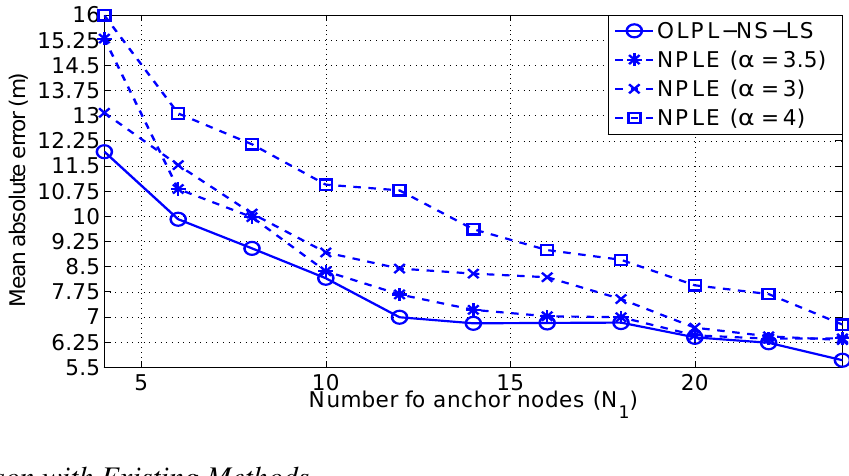
Figure 8. Mean absolute error versus number of anchor nodes ( N 1 ) ( solid line: lower distance selection, dashed line: non-path loss estimation ).